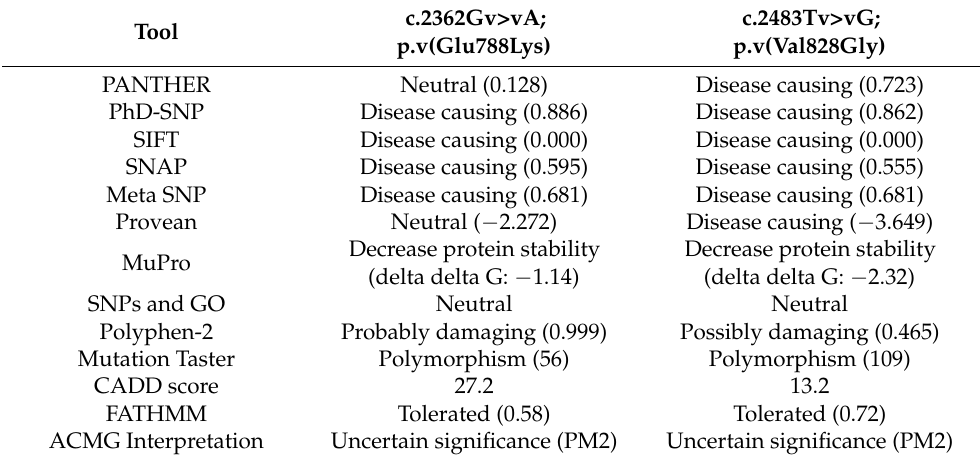
Table 1. Pathogenicity prediction of SYNE2 (NM_182914.3) variants by various in silico tools.